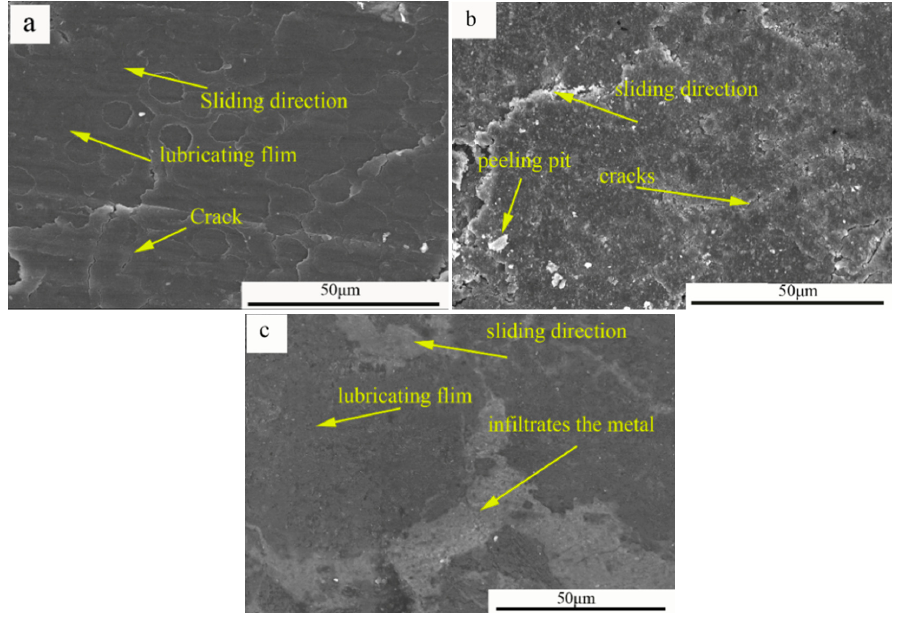
Figure 8. SEM micrographs of the worn surfaces of composites. ( a ) C/C (sample A), ( b ) C/C–Al–Mg (B2), and ( c ) the steeped metal slide (sample C).